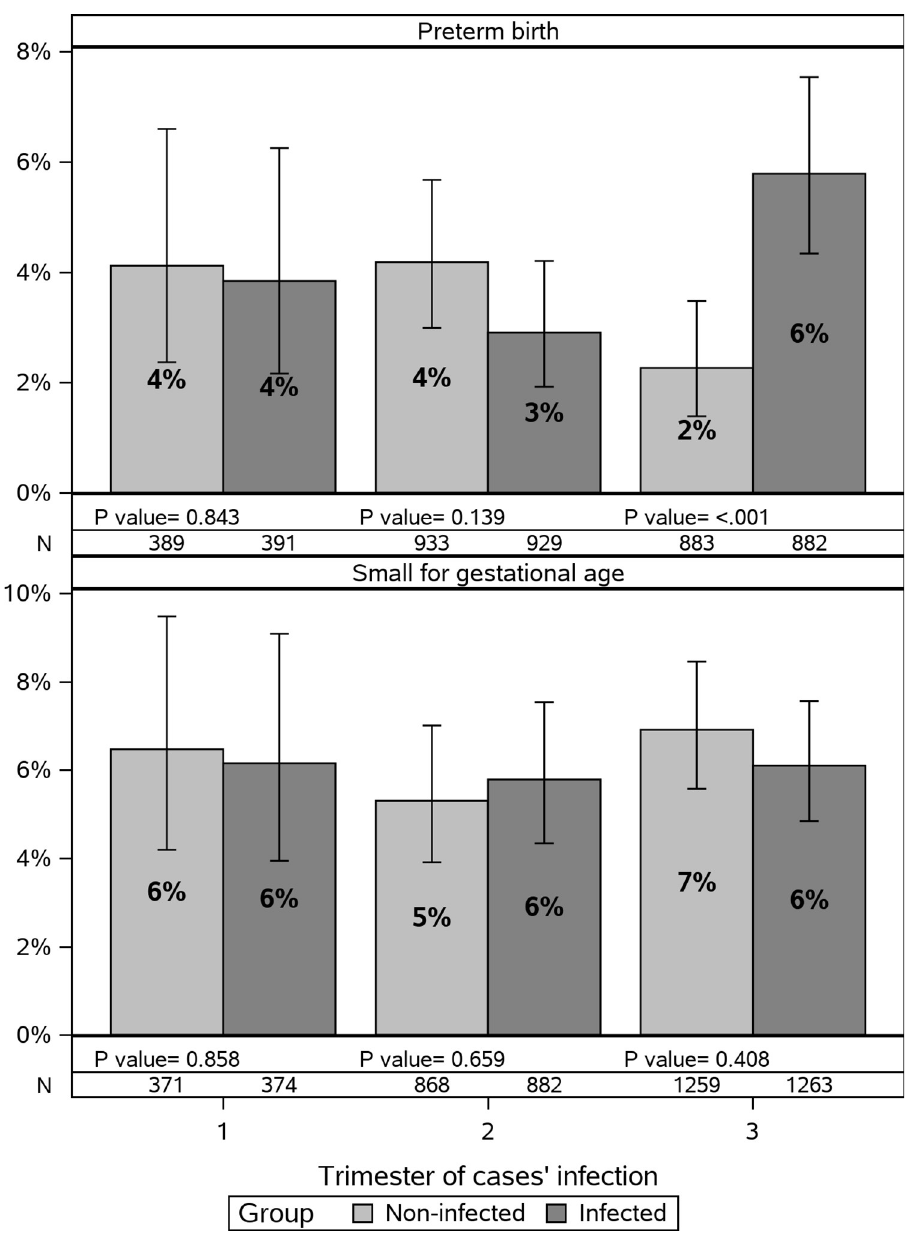
Fig 2. Frequency of pregnancy outcomes by group and trimester of infection with 95% confidence intervals. P values of group by trimester of cases’ infection in multivariate logistic regressions adjusted by age, sector, social economic status, cardiovascular disease, cancer, hypertension, diabetes, previous abortion and null